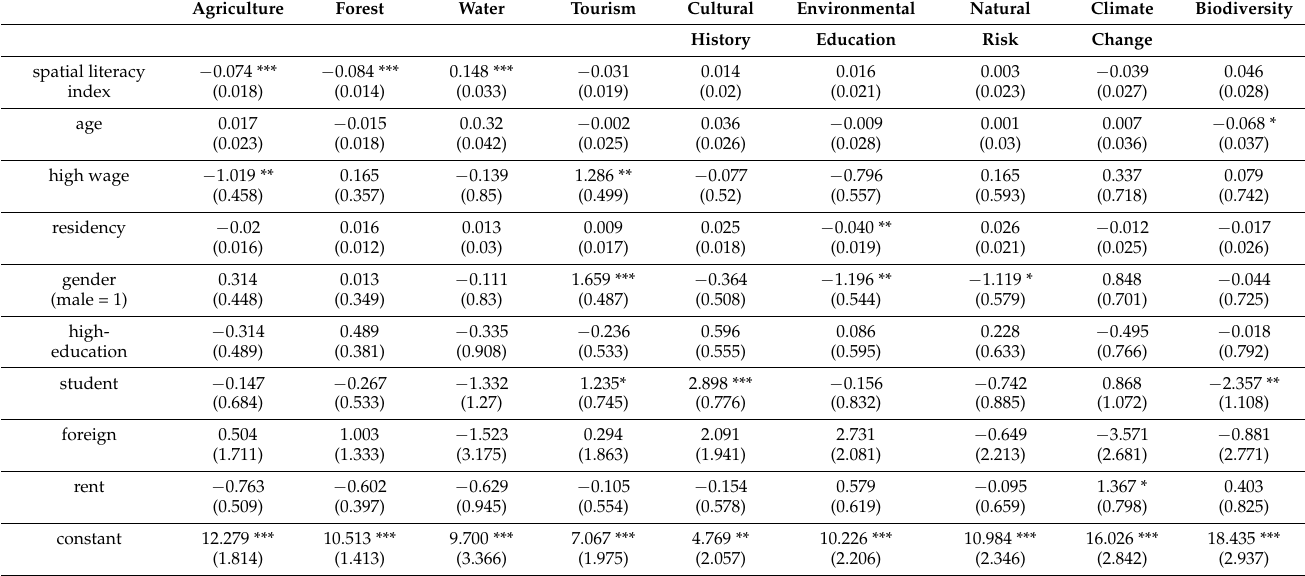
Table A3. Regression results for the one-stage model. These are the results that are reported in Table 4 of the main